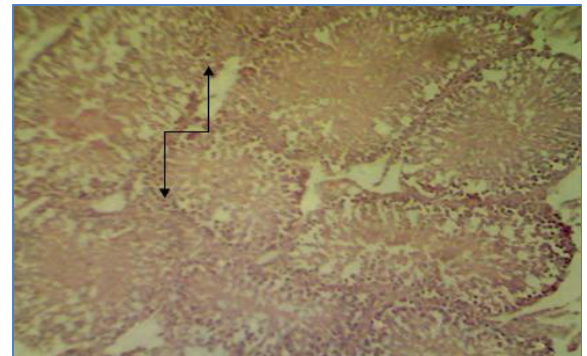
Figure, 6: Section in pituitary gland of animal treated with cadmium chloride and Eruca Sativa (G2) shows few vacuolation in the pars distalis ( ) with clear chromophobes cells ( ) and chromophils cells ( ) ( H and E stain 40X).